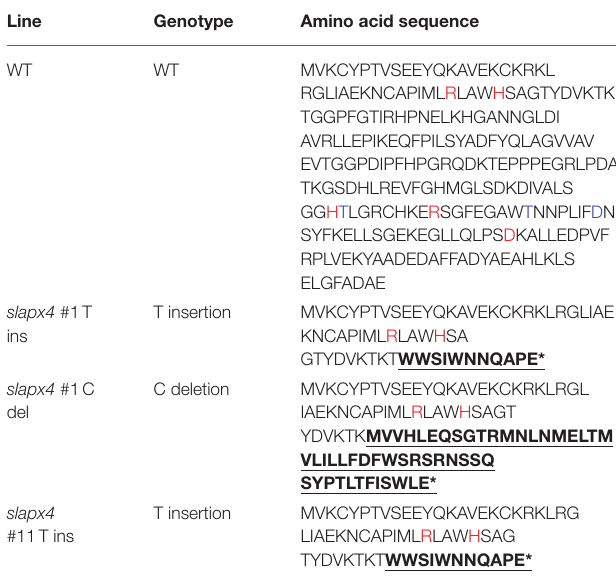
TABLE 2 | Amino acid sequence analysis of the target site in slapx4 mutant